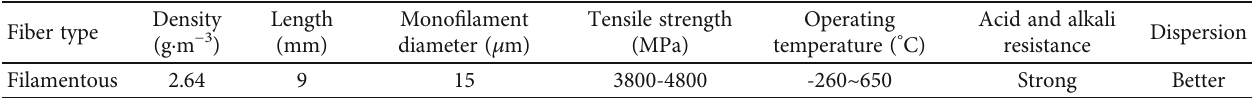
Table 2: Physical and chemical parameters of basalt fi bers.